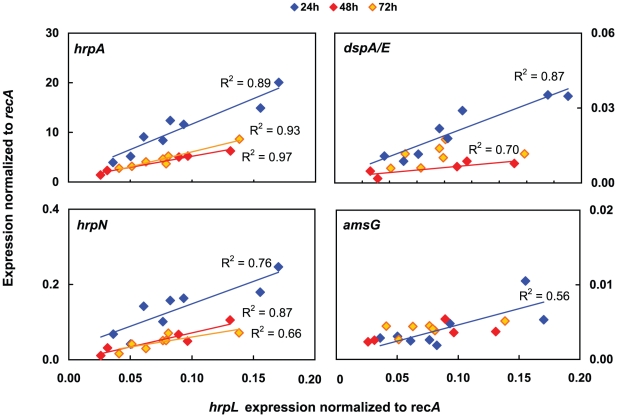
Correlation of gene expression with the transcriptional regulator hrpL in single flowers.Expression of hrpA, hrpN, dspA/E and amsG is plotted against expression of hrpL for the indicated times post inoculation (Set 1). All genes are normalized against recA expression. R2 values above 0.5 with linear regressions are shown.